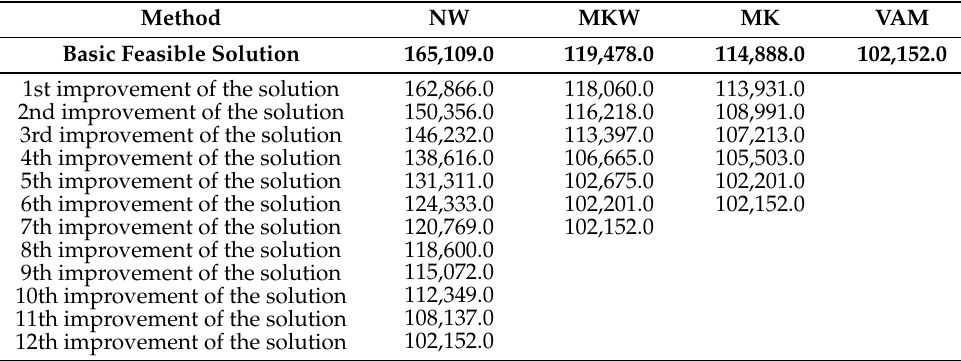
Table 14. Comparison of methods and costs of solutions ( e )